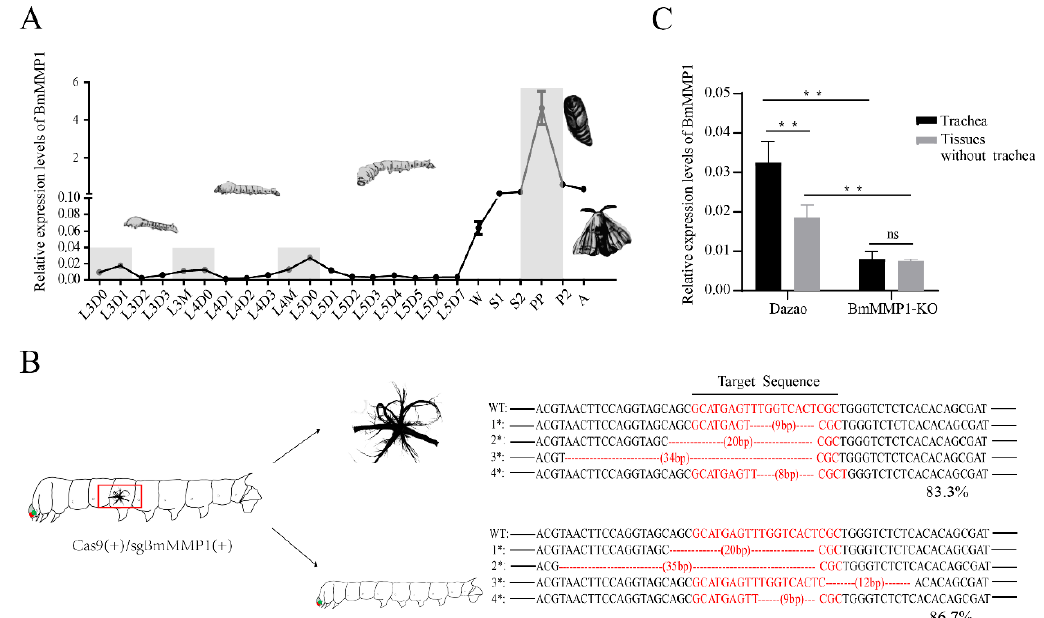
Figure 1. Analysis of expression characteristics of BmMMP1 in silkworm trachea. ( A ) The expressions of BmMMP1 mRNA levels during trachea development in B. mori . L3–L5, third to fifth larval instars; W, wandering stage; S, Spinning stage; PP, prepupal stage; P, pupal stage; A, adult stage. The gray rectangles were used to mark the BmMMP1 highly expressed periods. The morphology of silkworm at each stage appears in the corresponding developmental stage. ( B ) DNA sequencing analysis of the CRISPR/Cas9 editing BmMMP1 in trachea and tissues without trachea. 83.3% represented the knockout efficiency of BmMMP1 in the trachea and 86.7% represented that in tissues without trachea. The target sequence as the mark shows. ( C ) The expressions of BmMMP1 mRNA levels in the trachea and tissues without trachea of WT and mutants. The samples in results B&C are silkworms in L5D1. (ns, p ≥ 0.05; * *, p < 0.01).